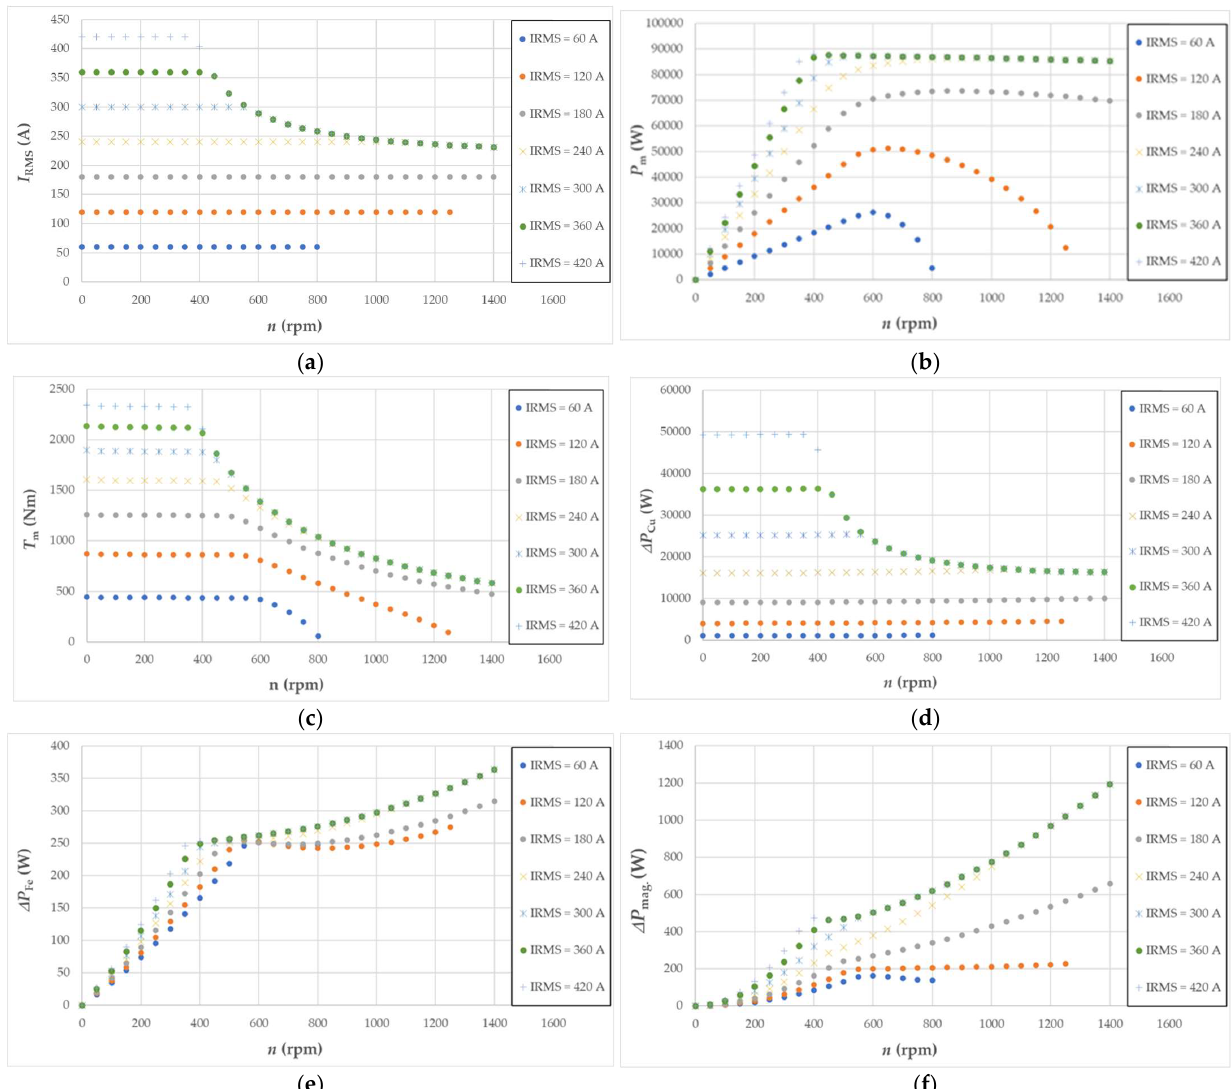
Figure 5. Calculated motor characteristics as a function of rotational speed: ( a ) supply current; ( b ) mechanical power; ( c ) torque; ( d ) power losses in the winding; ( e ) power losses in the magnetic core; ( f ) power losses in a permanent